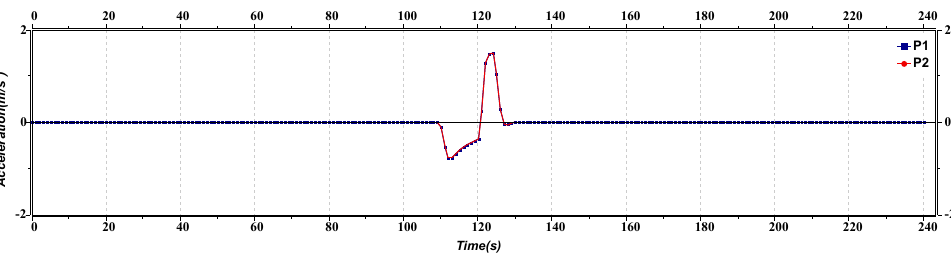
Figure 13. Acceleration versus time graph of lane change. Figure 14 represents the distance versus the time of inter-platoon lane change, specif- ically between the leader of both platoons. Initially, the distance between the platoon leaders is constant. As the lane change is about to occur, the inter-platoon distance deviates, with the first deviation occurring at around 30 s. The graph predicts that it is challeng- ing to maintain a constant distance between platoons during the lane change, but a safe distance is still maintained. This provides a research scope to formulate a critical safe distance model during the lane change, thus avoiding crashes. The proposed algorithm has focused on the safe distance between inter and intra-platoon to some extent which can be considered in future work.